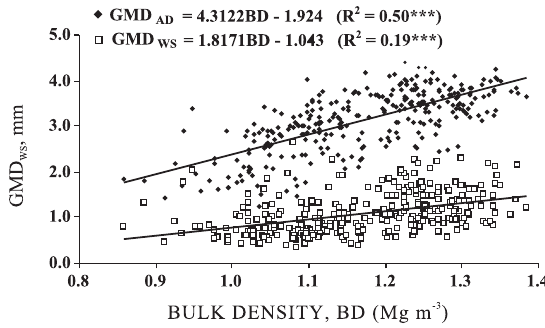
Figure 2. Correlation between bulk density (BD) with geometric mean diameter of air-dried (GMD ) and water-stable aggregates (GMD AD of cores sampled in four layers after nine years under five tillage systems and five nutrient